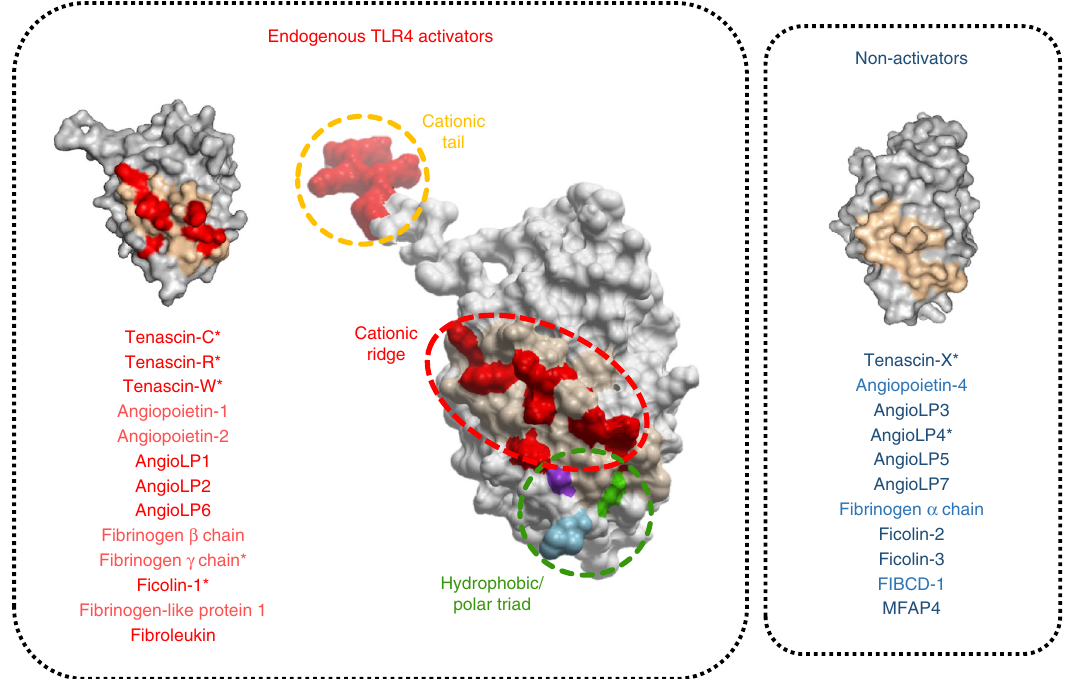
Fig. 8 A common danger domain revealed. Three distinct sites within the FBG domain of tenascin-C contribute to TLR4 activation (center panel); a cationic ridge made up of residues from loops 5 – 7 (pale orange with positive residues highlighted red), underneath which sits a triad of hydrophobic/polar residues from loop 7 (green, purple, and blue), plus a C-terminal cationic tail in loop 10 (positive residues highlighted red). The cationic ridge is the dominant in fl ammatory epitope; its deletion renders in fl ammatory stimuli inert and its ectopic expression can convert immunologically inactive proteins into TLR4 agonists. In addition to tenascin-C, in other proteins that contain FBG domains, possession of this in fl ammatory epitope also confers TLR4-activating capabilities, irrespective of protein family (*denotes validated domains). Together, these data reveal a common mechanism by which distinct in fl ammatory triggers, spanning a wide range of tissue locations, induced in response to a spectrum of different threats, can activate TLR4 to raise an immune